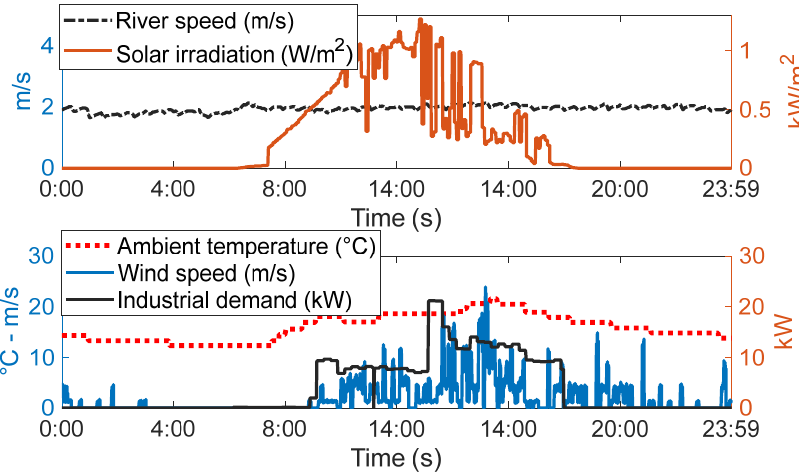
Figure 3. Input parameters, time interval: average values every second during a day.